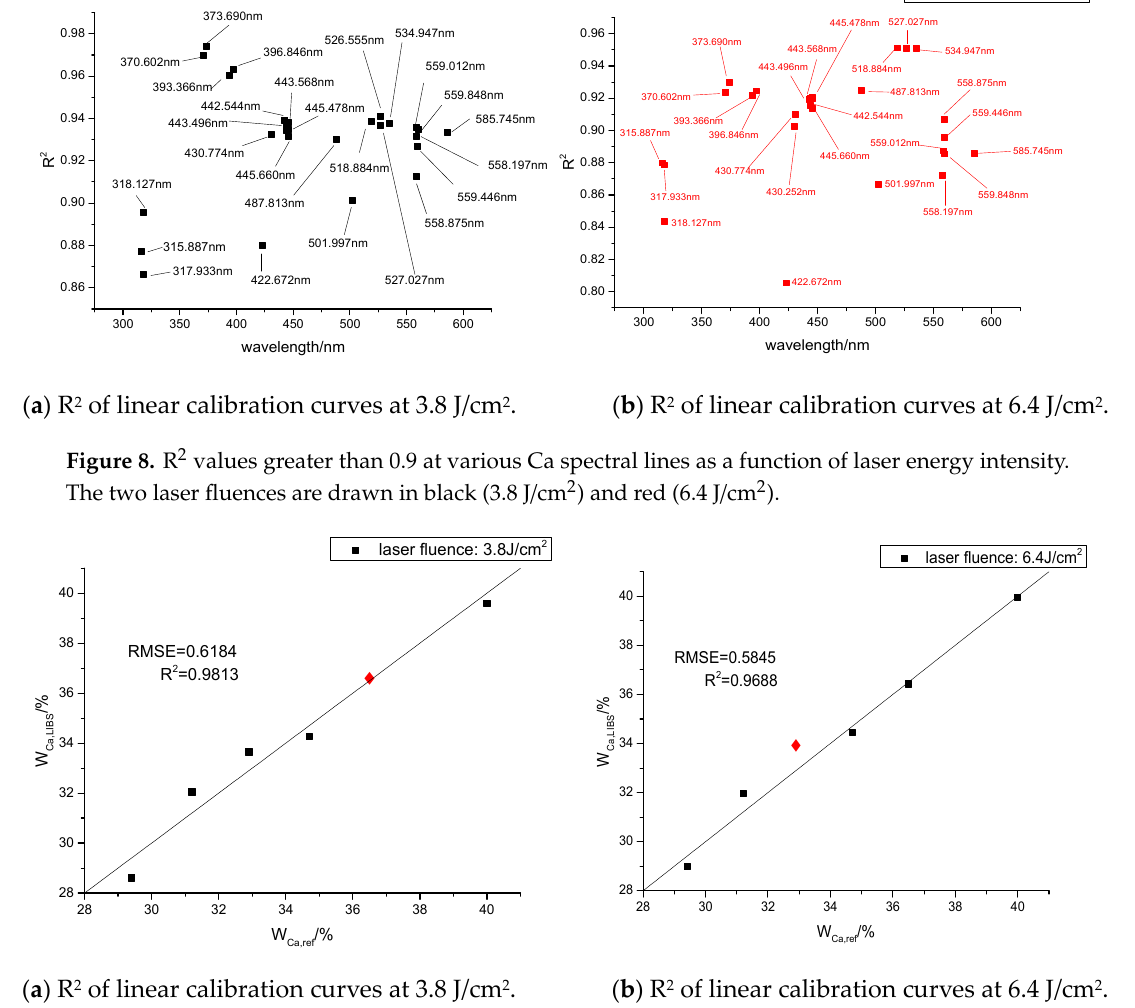
Figure 9. Results of 5-fold cross-validation of Ca data for PLSR (2 components).